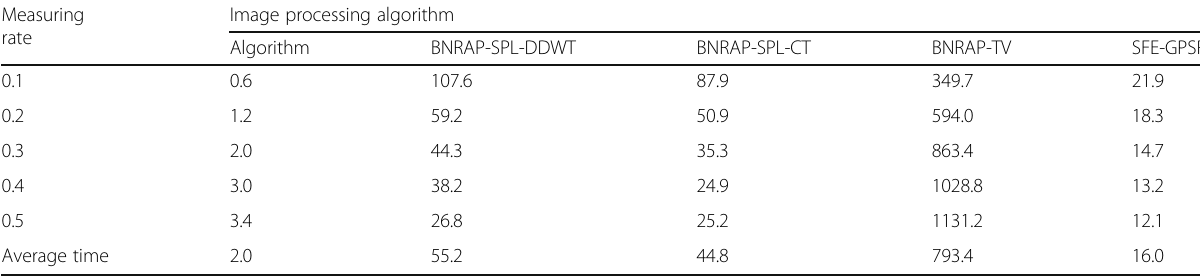
Table 2 The time consumed by various algorithms for image processing ( s ) Measuring